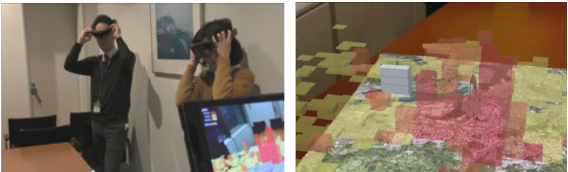
Figure 11. "AR Consensus-Formation System" for